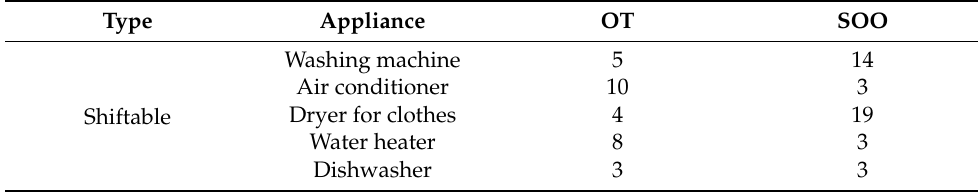
Table 4. The optimized operation times of the appliances in